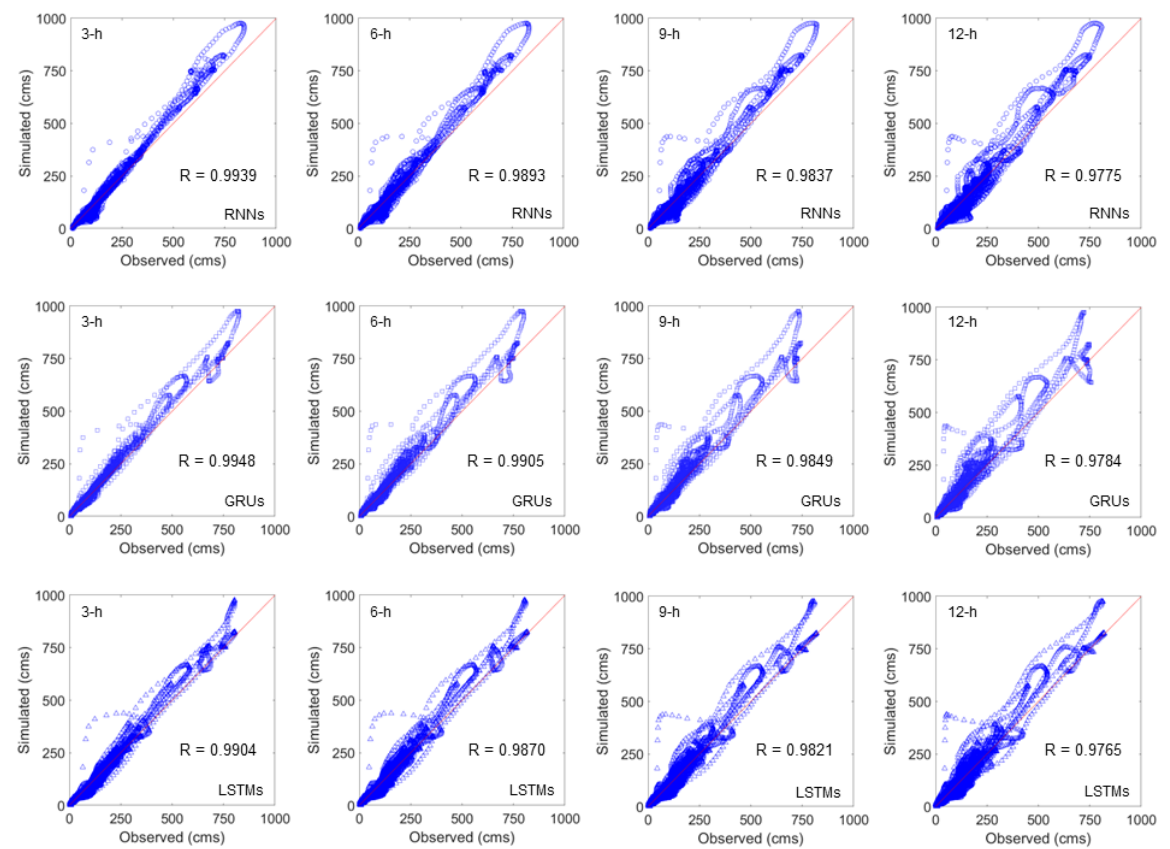
Figure 9. Scatter plots between observed data and the simulated prediction at 3-h, 6-h, 9-h, and 12-h of RNNs, GRUs, and LSTMs using the T C feature representations for the Loei river basin.